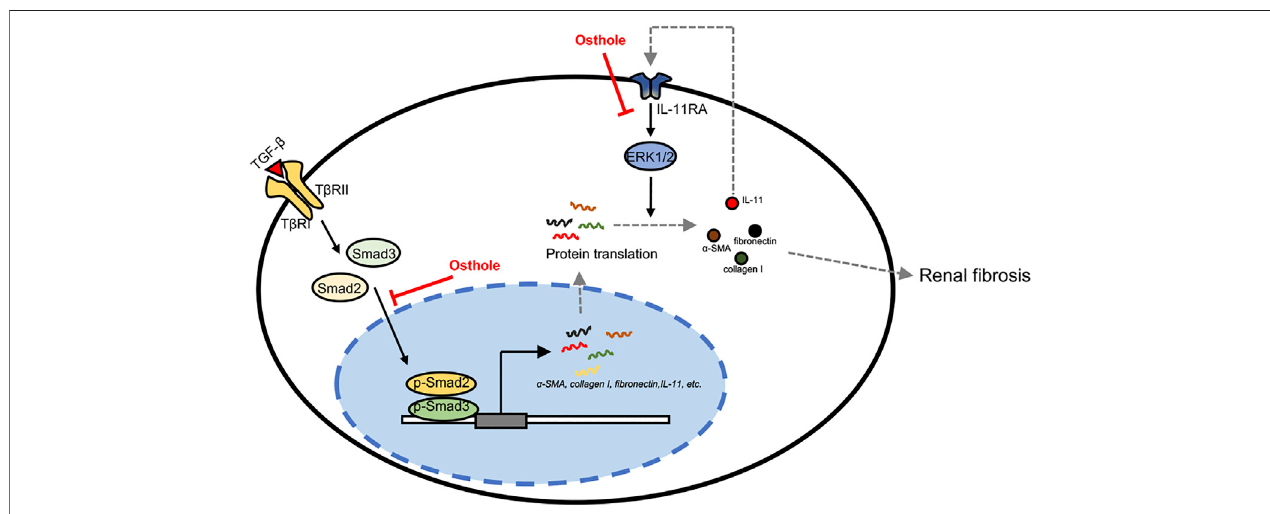
FIGURE 6 | The putative mechanism of osthole ’ s ameliorative effects on renal fi brosis. In the progression of renal fi brosis, activated TGF- β signaling promotes the transcription of fi brogenic genes, like α -SMA , collagen I, fi bronectin, IL-11, etc., by transcription factor Smad2/3 nuclear translocation. Meanwhile, the increased IL-11 may also enhance fi brosis proteins translation via activating IL-11/ERK1/2 signaling pathway. These processes eventually contribute to ECM deposition and fi brosis. In thisstudy,wefoundthatostholehasapreviouslyunrecognizedroleininhibitingIL-11/ERK1/2signalingpathway.Ontheonehand,ostholecaninhibittheactivation of TGF- β /Smad2/3 signaling, then reducing the transcription of fi brogenic genes, and thereby ameliorating fi brosis. In this process, IL-11/ERK1/2 signaling pathway is also inhibited due to IL-11 is one of the target genes of TGF- β /Smad2/3 signaling. On the other hand, osthole can directly inhibit IL-11/ERK1/2 signaling pathway independent of TGF- β 1 signaling, then decreasing the translation of fi brosis proteins, fi nally ameliorating fi brosis. In summary, our work demonstrated that the anti fi brogenic effect ofosthole isnotonly mediatedbyTGF- β /Smad2/3 signaling,but also directlymediatedby IL-11/ERK1/2 signaling pathway independent ofTGF- β 1